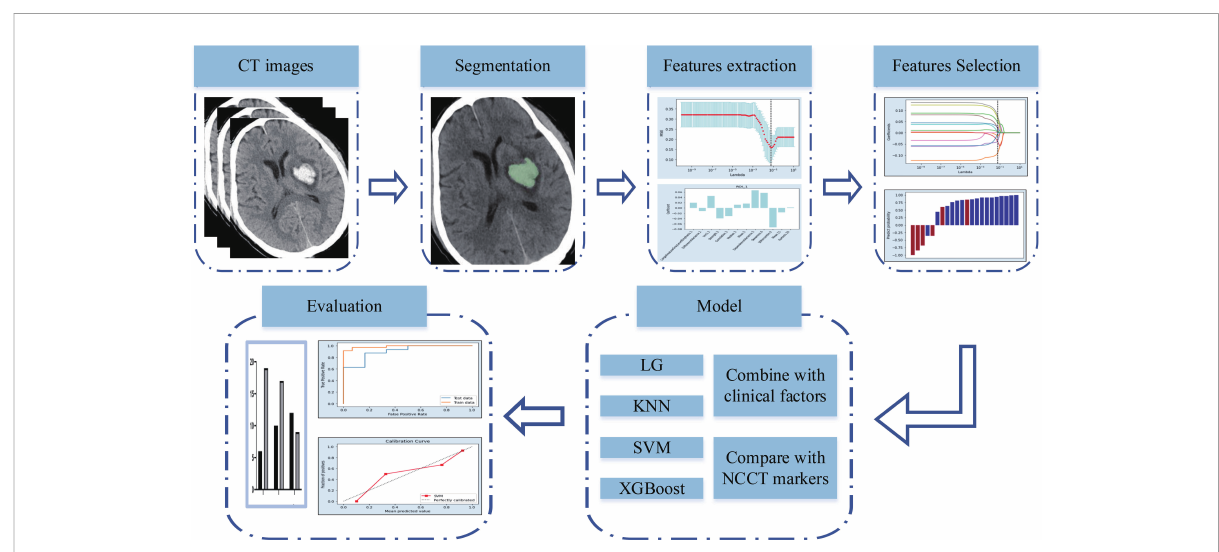
FIGURE 1 Flowchart of (NCCT-based radiomics. NCCT: non-enhanced computed